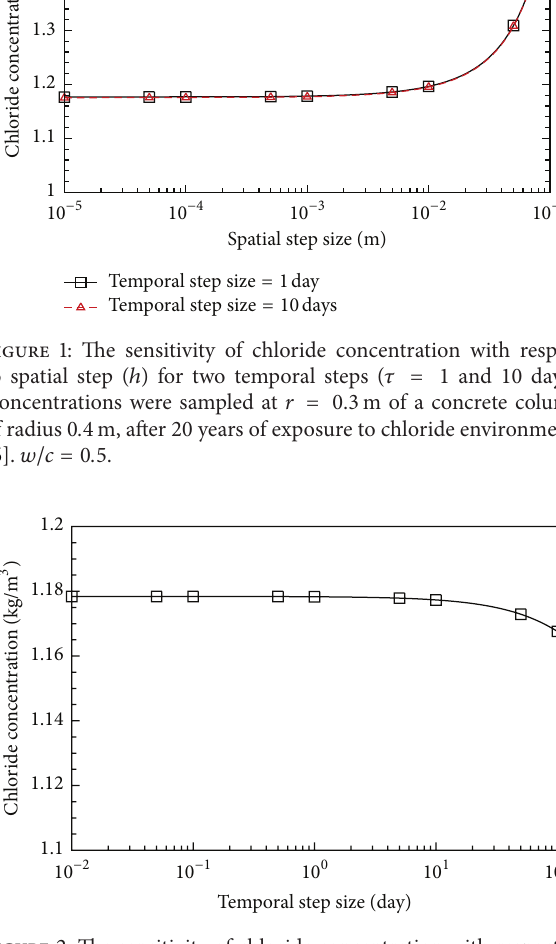
Figure 2: The sensitivity of chloride concentration with respect to the temporal step ( 𝜏 ) for ℎ = 1mm. Concentrations were sampled under the exact same condition as that of Figure 1.